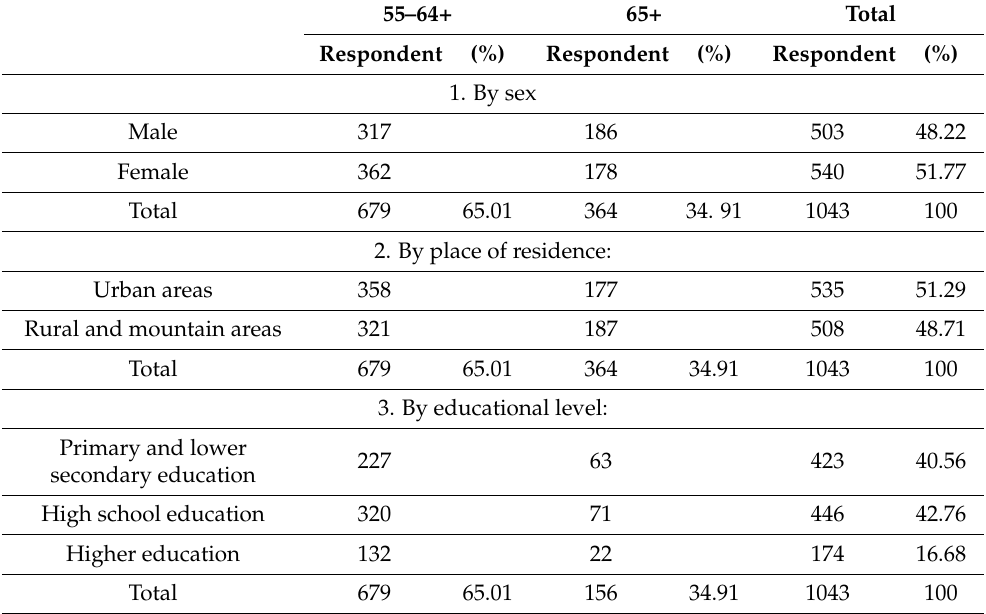
Table 1. Summary of the survey sample analysis by sex, place of residence, and educational